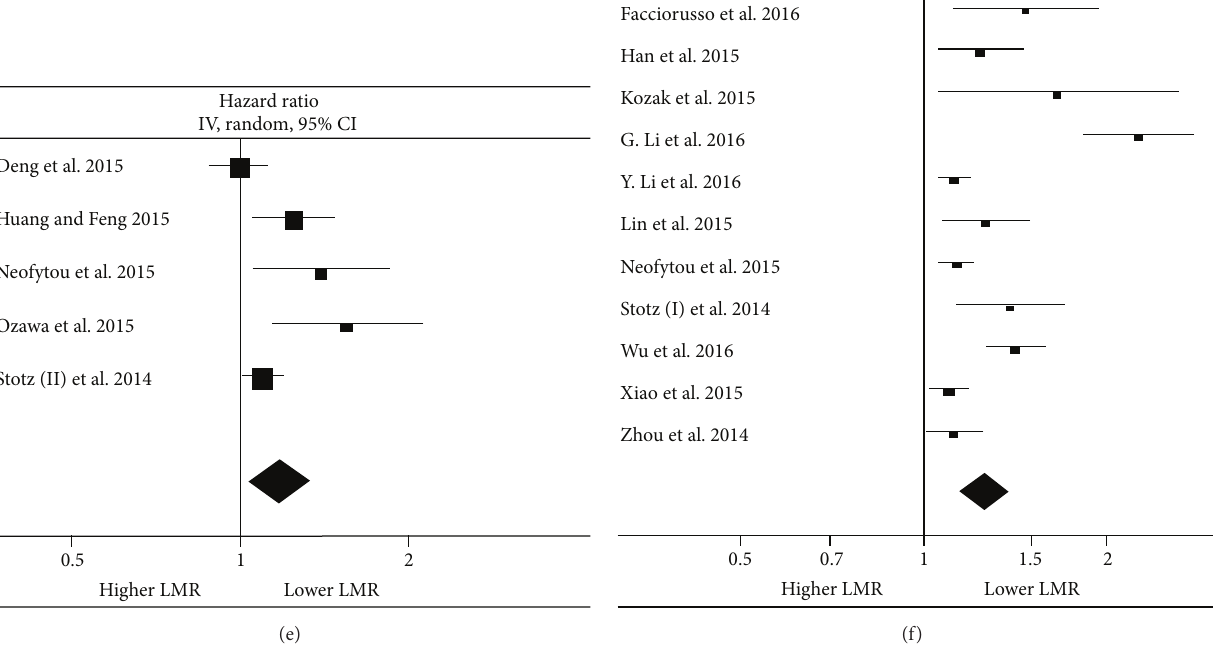
Figure 2: Main forest plots of meta-analysis. Forest plots of the association between lymphocyte to monocyte ratio and overall survival (OS), cancer-specific survival (CSS), and disease or recurrence-free survival (DFS/RFS). Hazard ratios (HRs) for each study are represented by the squares. The size of the data markers (squares) corresponds to the weight of the study in the meta-analysis, and the horizontal line crossing the square represents the 95% confidence interval (CI). All statistical tests were two-sided. (a) Meta-analysis of patients OS from univariate analysis (UVA); (b) meta-analysis of patients CSS from UVA; (c) meta-analysis of patients DFS/RFS from UVA; (d) meta-analysis of patients OS from multivariate analysis (MVA); (e) meta-analysis of patients CSS from MVA; (f) meta-analysis of patients DFS/RFS from